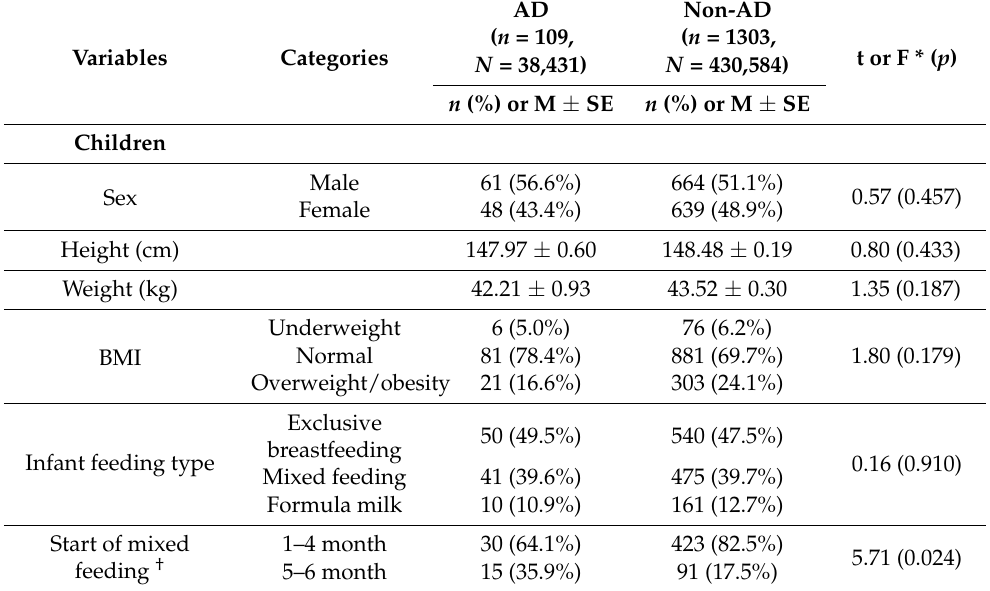
Table 1. Comparison of general characteristics in atopic dermatitis group and non-atopic dermatitis group ( n = 1412, N =